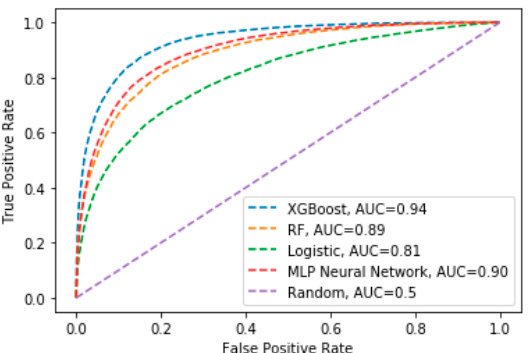
Figure A1. Similar to Figure 3, but for the models which do not include wildfire history variables.